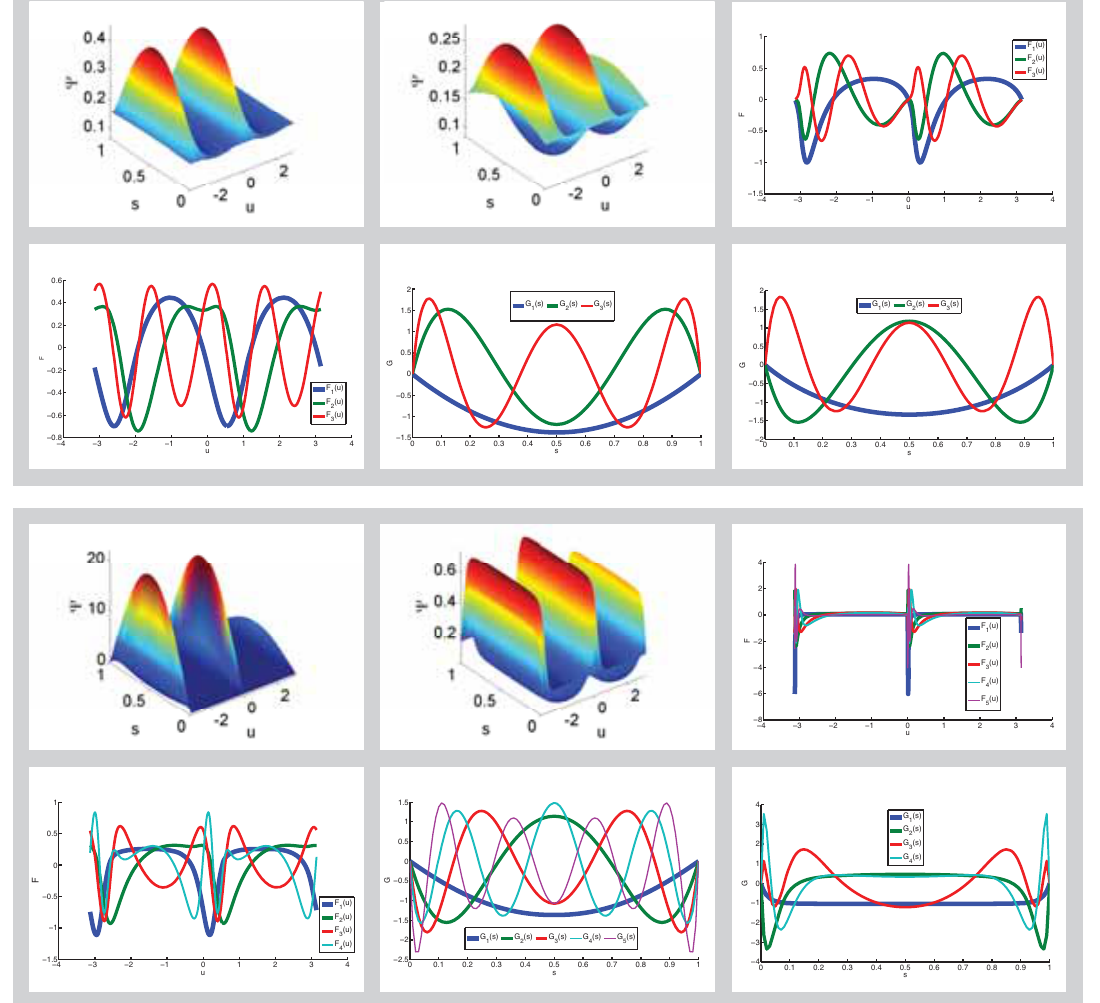
Figure 3 (above): Comparison of the Doi- Edwards model (left) and the Öttinger one (right) in a steady state 2D shear flow characterized by We = 1 and d = d = 1/ l : (top) distribu- 1 1 tion functions, (middle) reduced approximation bases related to the orienta- tion coordinate, and (bot- tom) reduced approxima- tion bases related to the contour length coordinate. Figure 4: Comparison of the Doi- Edwards model (left) and the Öttinger one (right) in a steady state 2D shear flow characterized byWe = 100 and d = d = 1/ l : (top) distri- 1 1 bution functions; (middle) reduced approximation bases related to the orienta- tion coordinate and (bot- tom) reduced approxima- tion bases related to the contour length